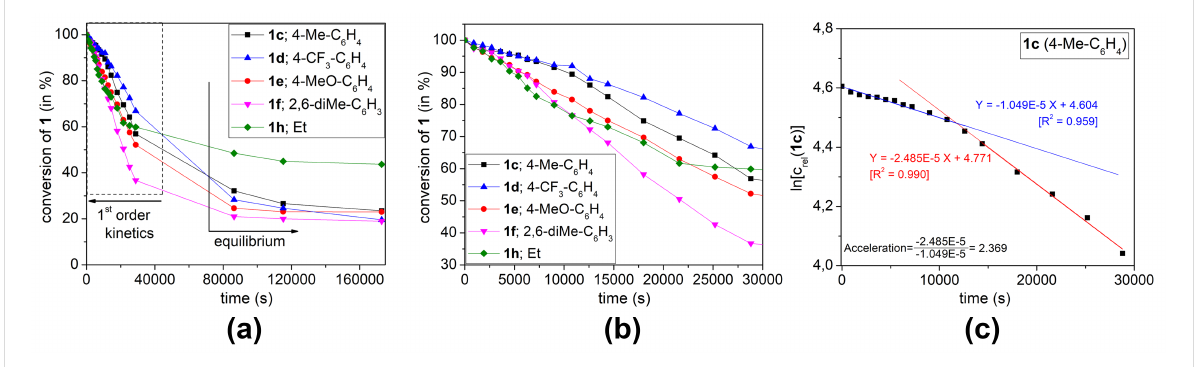
Figure 2: The full time experimental kinetic curves (a); The initial part of the kinetic curves of 1c – f and 1h (b); Initial and second fittings on the kinetic curve of 1c (c). For more kinetic curves, see Supporting Information File 1, Figure S1).